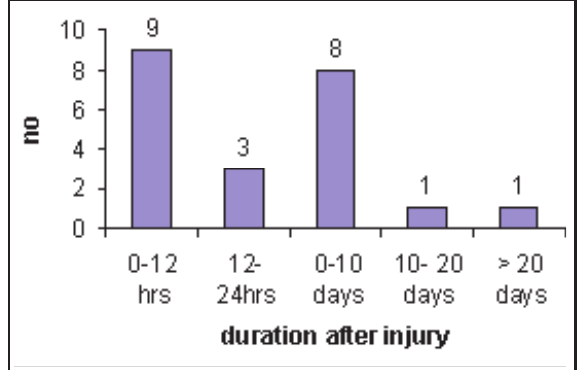
Fig. 4: Patient’s arrival at hospital after injury. Most of the patient (54%) came to emergency department within 24 hrs of injury.